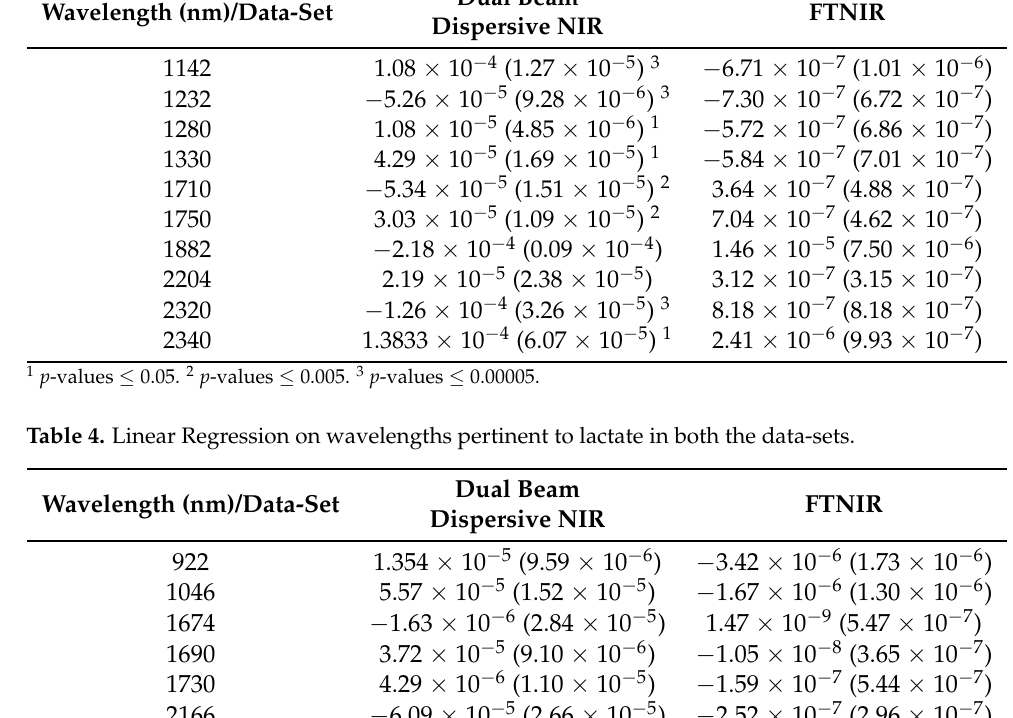
Table 3. Linear Regression on wavelengths pertinent to lactate in both the data-sets. Wavelength (nm)/Data-Set